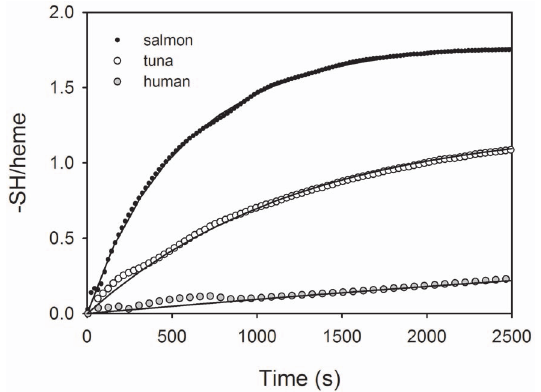
Figure 2. Salmon and tuna Mbs have faster reacting Cys than human Mb. Time course of the reaction of 4-PDS with accessible free thiols of salmon (black dots), tuna (white circles) and human Mb (grey circles) were measured in 50 mM Hepes, pH 7.2 at 20 u C at a ratio of 4:1 4-PDS/heme. Data fittings by double (salmon) or single (tuna and human) exponential equations are